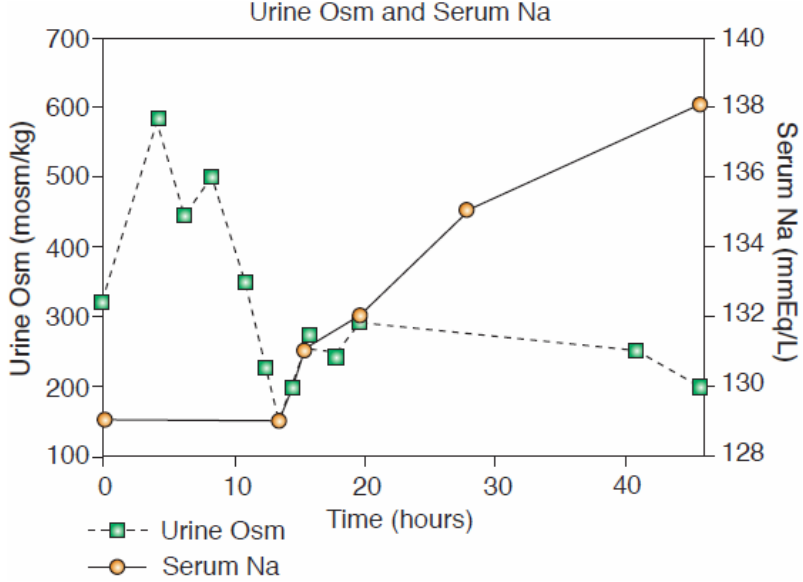
Figure 2. Correction of serum sodium and achievement of dilute urine after saline infusion (with permission, Kidney International , Maesaka J. K.